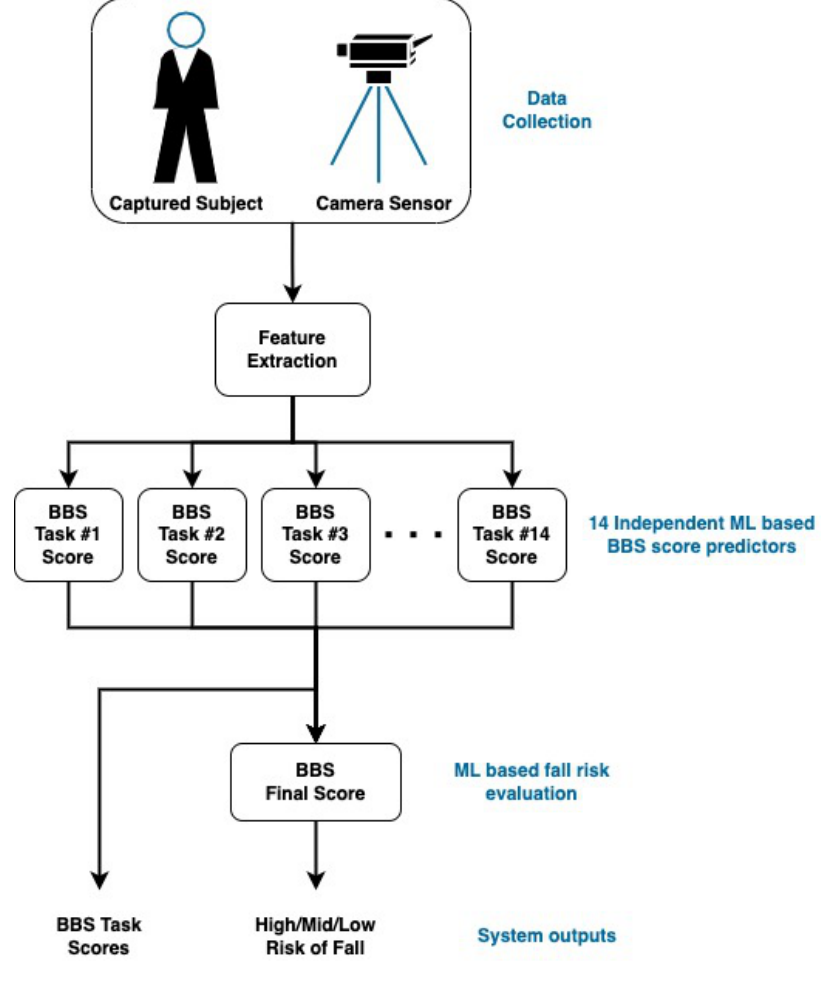
Figure 1. Schematic diagram of the BBS score and fall risk prediction